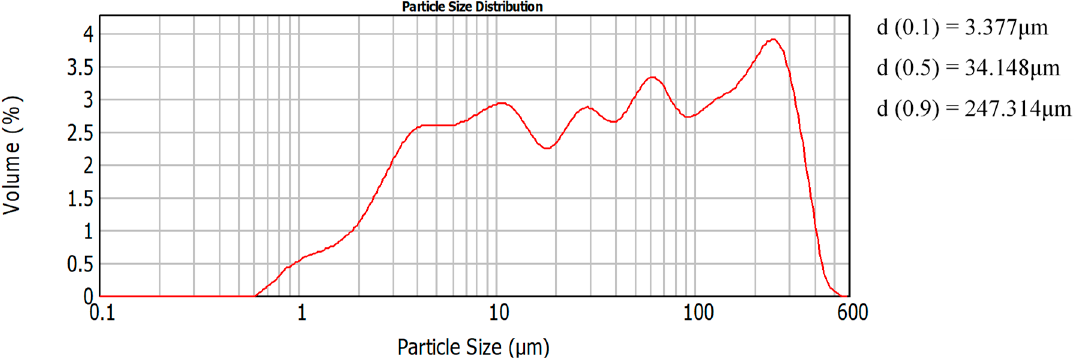
Figure 1. The particle size of Cretan clay used.